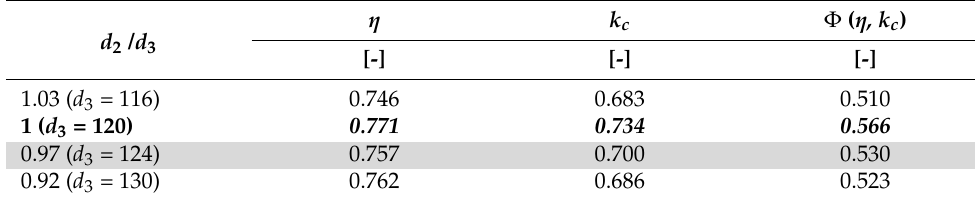
Table 7. The effect of the inlet diameter of the guide vanes.